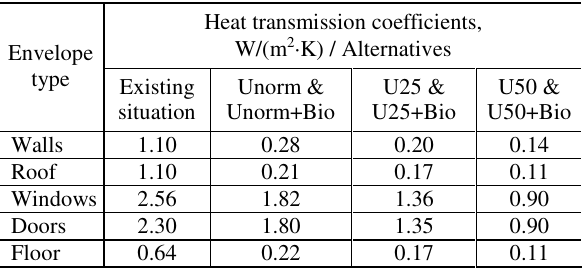
Table 1. Envelope heat transmission coefficient of each alternative